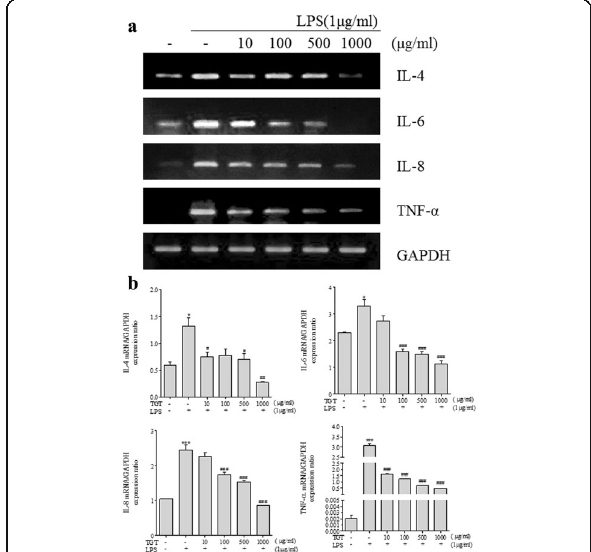
Fig. 4 Effect of TGT on expression of pro-inflammatory cytokines in LPS stimulated HaCaT cells. a LPS-stimulated HaCaT cells were treated with or without different doses of TGT for 24 h. Cytokine mRNA levels were measured by RT-PCR. b The density of each band was calculated with image processing program, Image J, and represented as bar graph. *; compared to control. #; compared to stimulated cells. Control; HaCaT with LPS ( − ), Stimulation; HaCaT with LPS